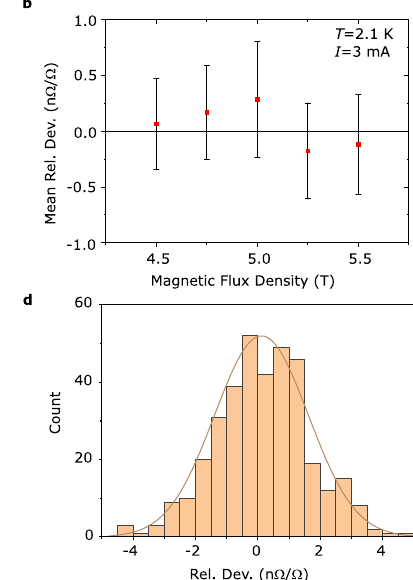
Fig. 2 | Direct comparison measurements of epigraphene arrays. a Precision cryogenic current comparator (CCC) measurements of subarray versus subarray comparisonwhichshowstheirrelativedeviationatacertain magnetic fl uxdensity. Thismeasurementconsistsof53CCC-readings,eacharound20minlong.Theerror bars represent one standard deviation and are later used as weights in the fi nal weightedmean,whichinthiscaseis0.06n Ω / Ω . b Precisionmeasurementstakenat different magnetic fl ux density show the mean relative deviation between the two subarrays. Each point is the weighted mean of ≥ 45 CCC-readings (like those in a ), and the error bars represent one standard deviation of the mean, derived from Allan deviation at 10 4 s (see c ) for each measurement at a certain magnetic fl ux